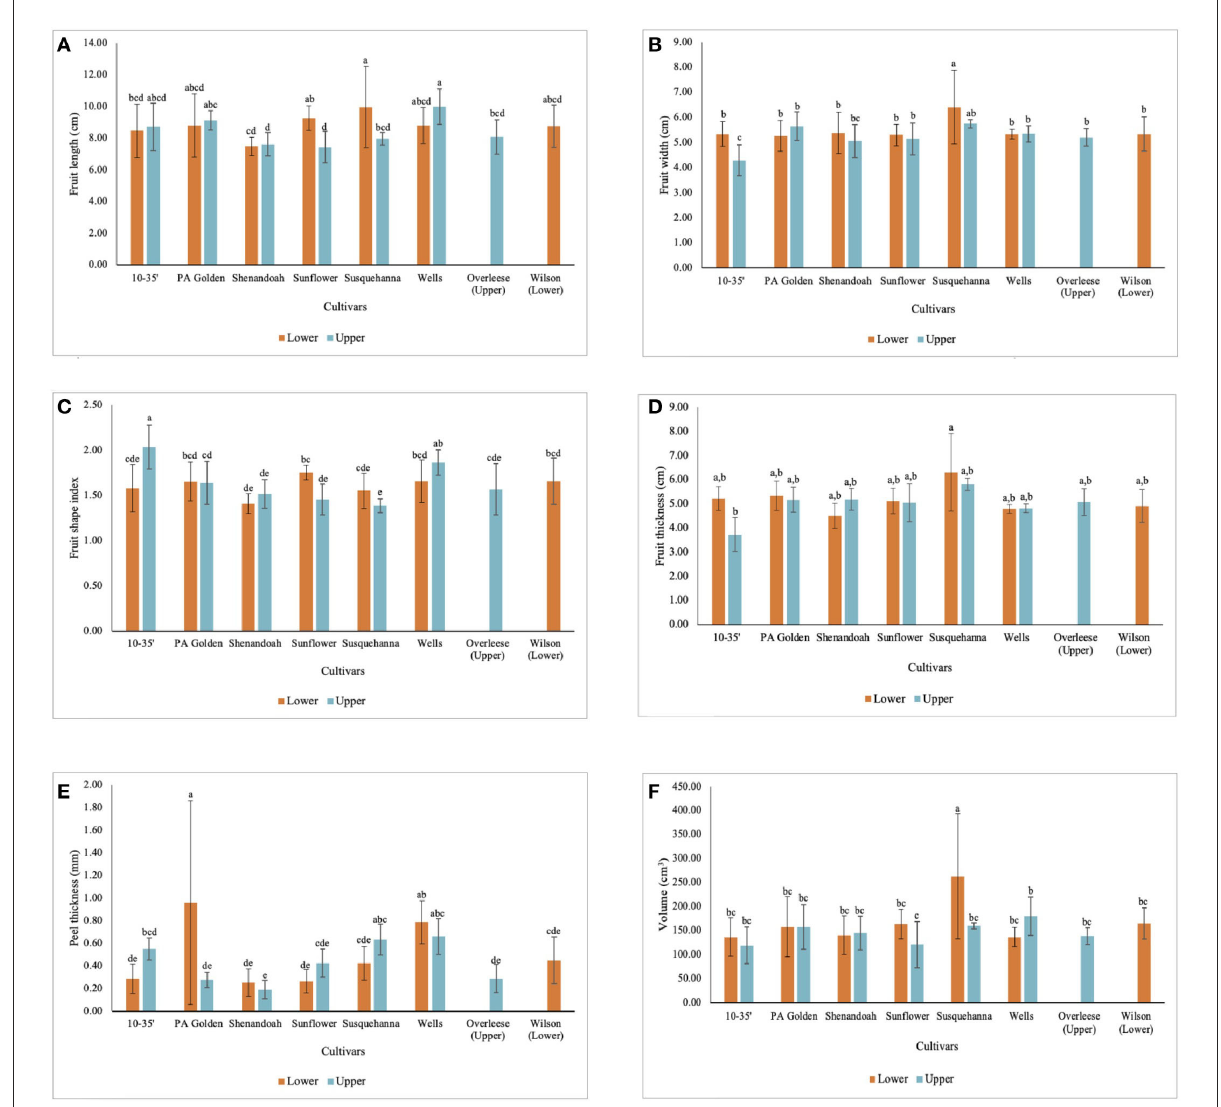
FIGURE2 Dimensional characteristics of pawpaw fruits from different cultivars in the Lower and Upper orchards showing (A) fruit length, (B) fruit width, (C) fruit shape index, (D) fruit thickness, (E) peel thickness and (F) volume of